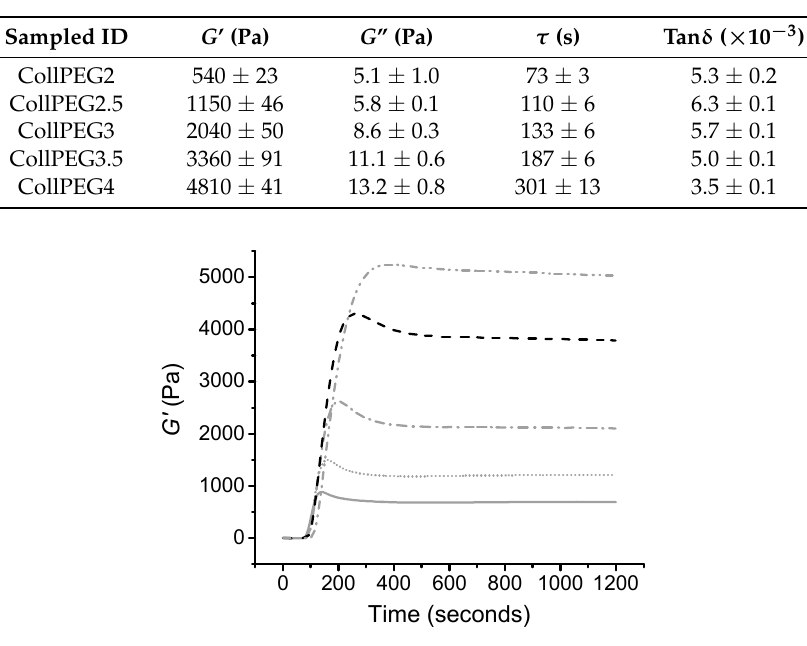
Table 2. Mechanical and physical properties of four thiol-ene collagen-PEG hydrogels using LAP (0.5% ( w / v )) Data presented as means ± SEM.